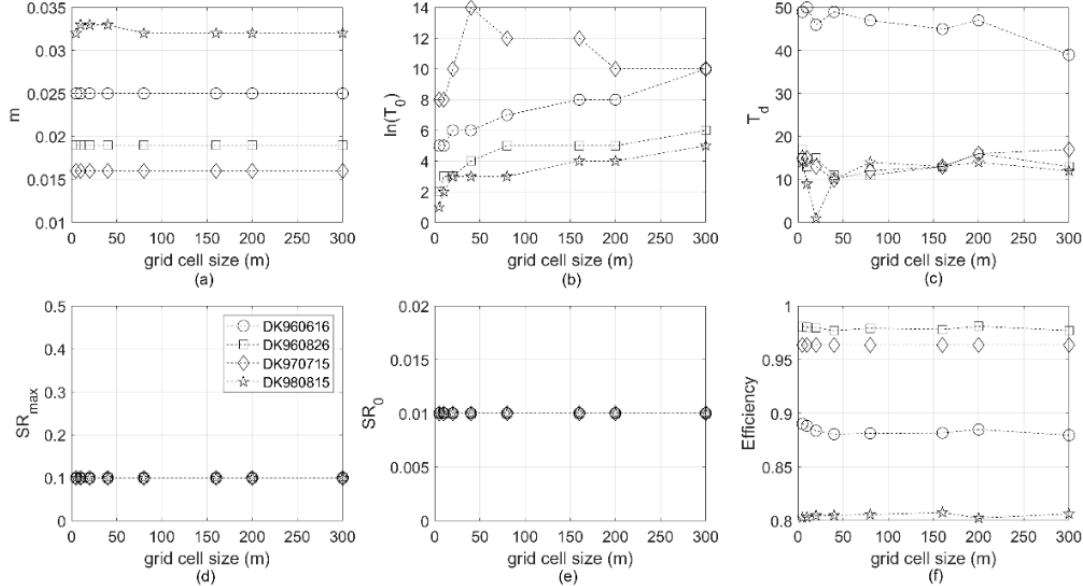
Figure 10. Optimized parameters depending on DEM resolutions in each hydrologic event, the Dongkok watershed. ( a ) exponential storage parameter (m), ( b ) soil–water permeability coe ffi cient ( ln ( T 0 ) ), ( c ) unsaturated lag time ( T d ), ( d ) maximum vegetation storage ( SR max ), ( e ) Vegetation deficiency ( SR 0 ), ( f ) model e ffi ciency.